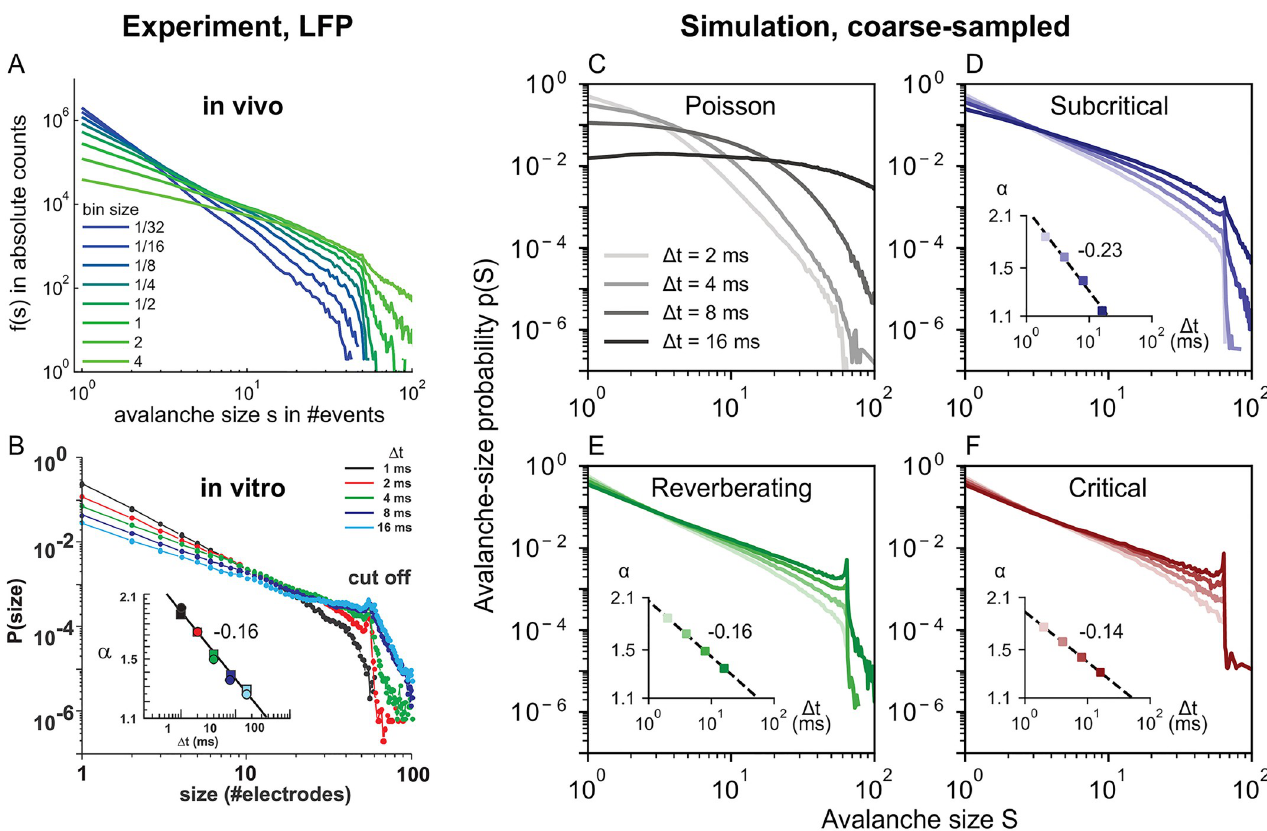
Fig 6. In vivo and in vitro avalanche-size distributions p ( S ) from LFP depend on time-bin size Δ t . Experimental LFP results are reproduced by many dynamics states of coarse-sampled simulations. A : Experimental in vivo results (LFP, human) from an array of 60 electrodes, adapted from [43]. B : Experimental in vitro results (LFP, culture) from an array with 60 electrodes, adapted from [1]. C–F : Simulation results from an array of 64 virtual electrodes and varying dynamic states, with time-bin sizes between 2 ms � Δ t � 16 ms, γ = 1 and d E = 400 μ m. Subcritical, reverberating and critical dynamics produce approximate power-law distributions with bin-size-dependent exponents α . Insets : Log-Log plot, distributions are fitted to p ( S ) � S − α , fit range S � 50. The magnitude of α decreases as Δ t − β with − β indicated next to the insets, cf. Table